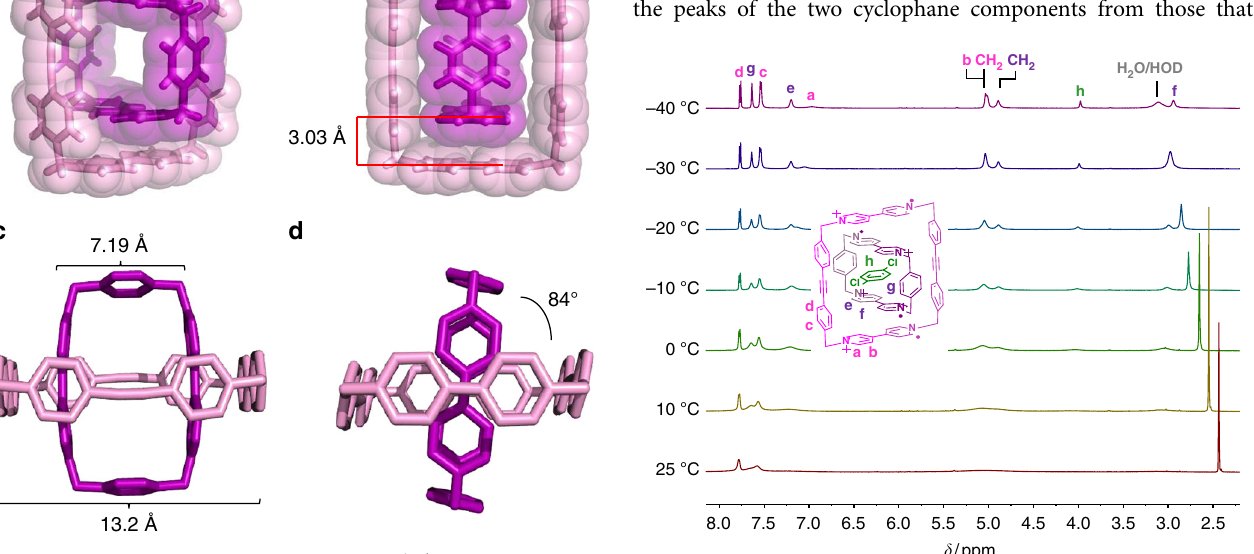
Fig. 6 Solid-state superstructures of [ CBPQT ⊂ 1 ] 4( + (cid:129) ) . a Perspective and b plan views depicted as tubular and space- fi lling representations. c , d Different side-on views, depicted as tubular representations. Hydrogen atoms in c and d are omitted for the sake of clarity